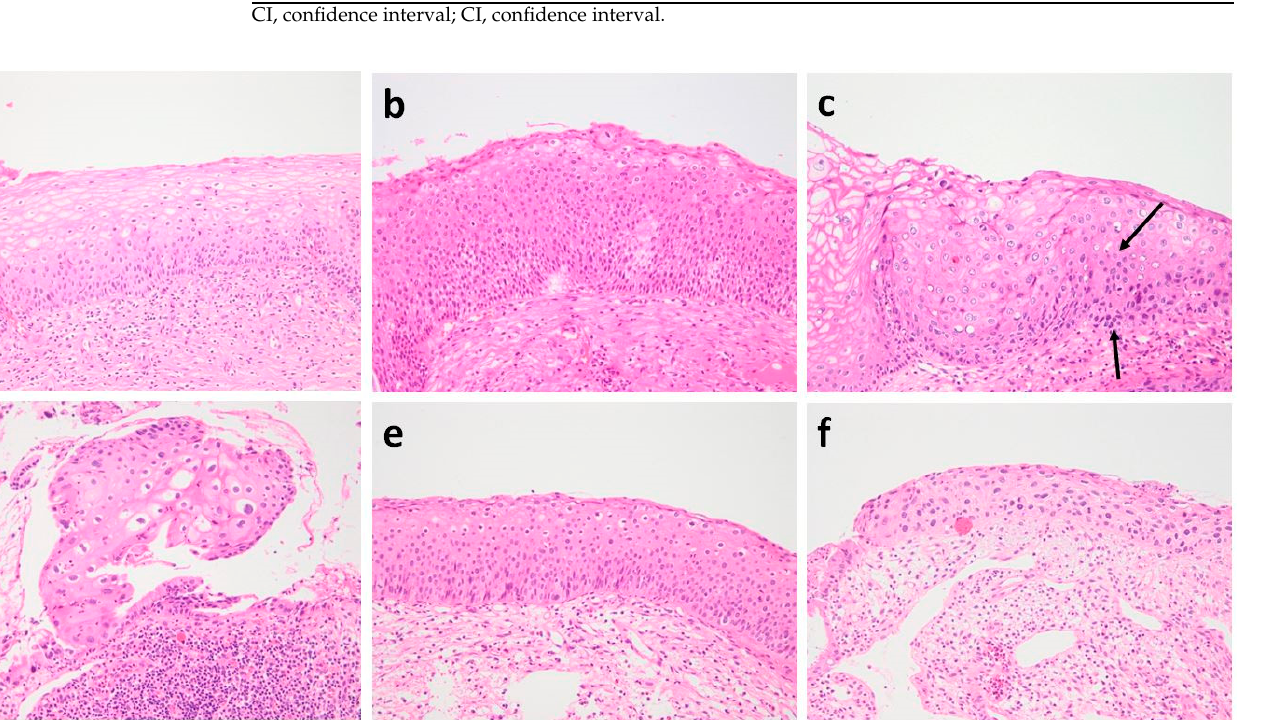
Figure A1. Histology of misclassified cases by CNN models. A case with scarce koilocytotic cells but basal atypia was false-negative ( a ). CIN3 showing basal/parabasal-type atypia throughout most of the epithelium but not all was downgraded to CIN2 ( b ). CIN2 ( c ) downgraded as CIN1 showed koilocytotic changes in the upper half and maturation in upper most layers but had atypia focally extending to the lower half of the epithelium (black arrow). In CIN1 upgraded as CIN2, the epithelium was disoriented ( d ). CIN2 with koilocytosis ( e ) and atrophic CIN2 ( f ) were upgraded as CIN3.